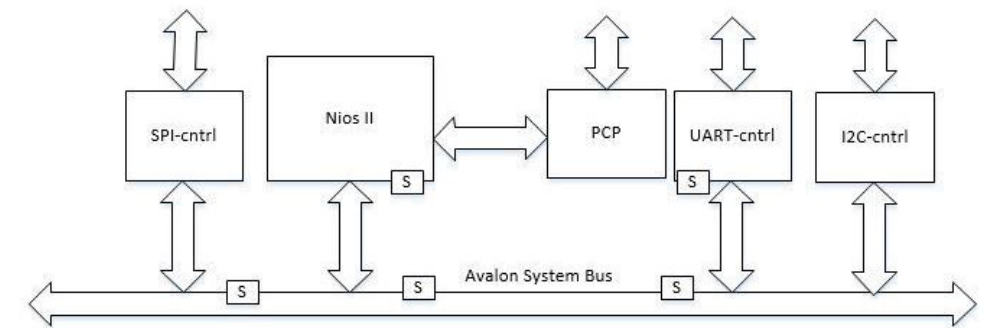
Figure 4. Hardware platform of a typical SPOF-slave: Nios II represents the application processor, PCP represents the POWERLINK communication processor, UART, SPI and I2C-cntrl represent controllers for interfacing with different buses, while S represents sniffers, part of the monitoring